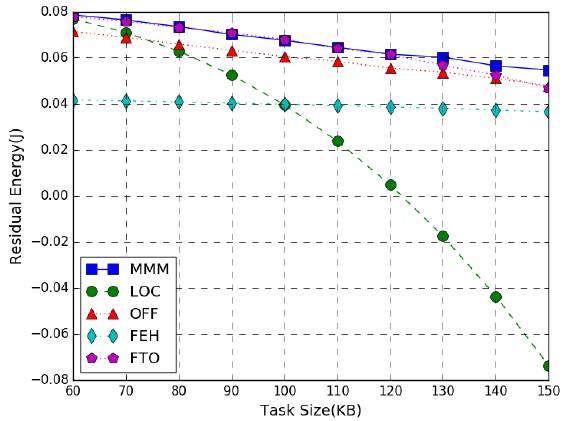
Figure 4. Task size vs. residual